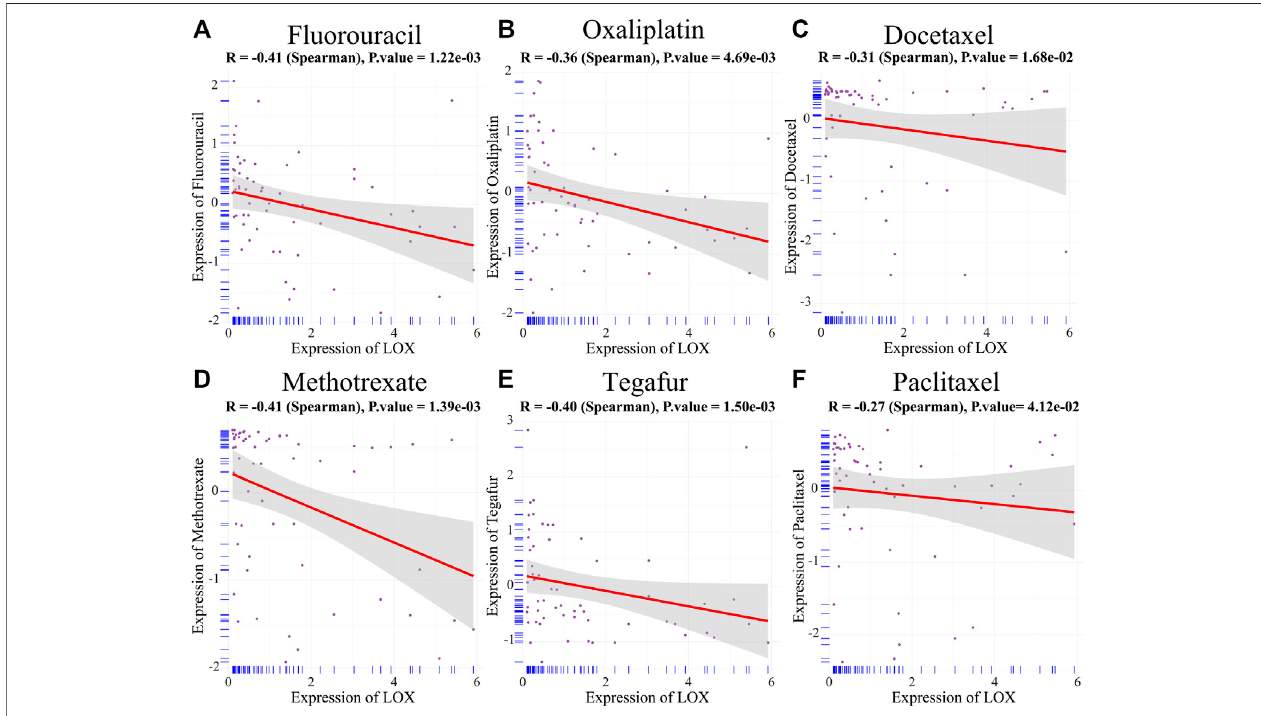
FIGURE 9 | The overexpression of LOX was positively associated with immune checkpoints. (A – G) The relationship between LOX expression and immune checkpoints,includingCTLA4 (A) ,CD274 (B) ,HAVCR2 (C) ,LAG3 (D) ,PDCD1 (E) ,PDCD1LG2 (F) ,andTIGIT (G) inTIMERdatabase. (H – N) Theexpressionofimmune checkpoints in high LOX expression and low LOX expression in TCGA